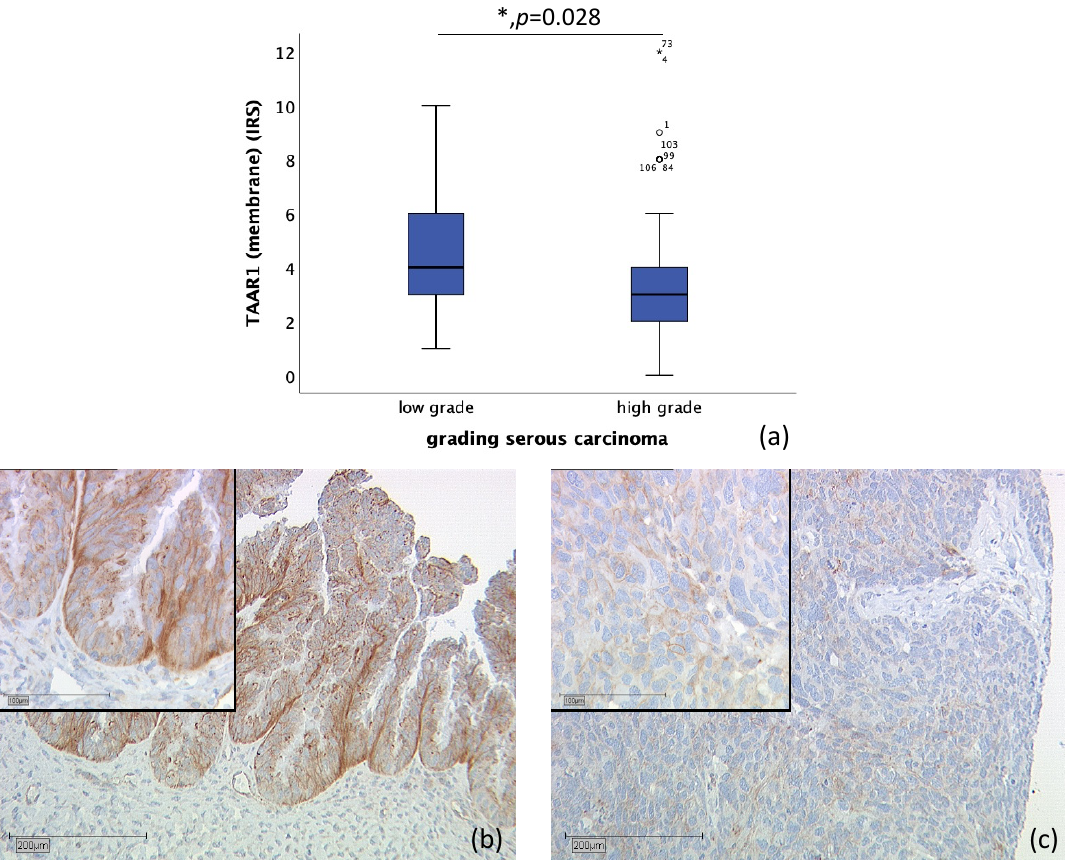
Figure 3. Correlation of membrane TAAR1 expression with grading in serous carcinoma ( p = 0.028) ( a ) boxplot of membrane TAAR1 expression and grading in serous carcinoma ( b ) low grade serous carcinoma ( n = 22) with a membrane TAAR1 IRS of 4, magnification ×10 and ×25 in the inset ( c ) high-grade serous carcinoma ( n = 71) with a membrane TAAR1 IRS of 2, magnification ×10 and ×25 in the inset; * p < 0.05 was considered statistically significant.